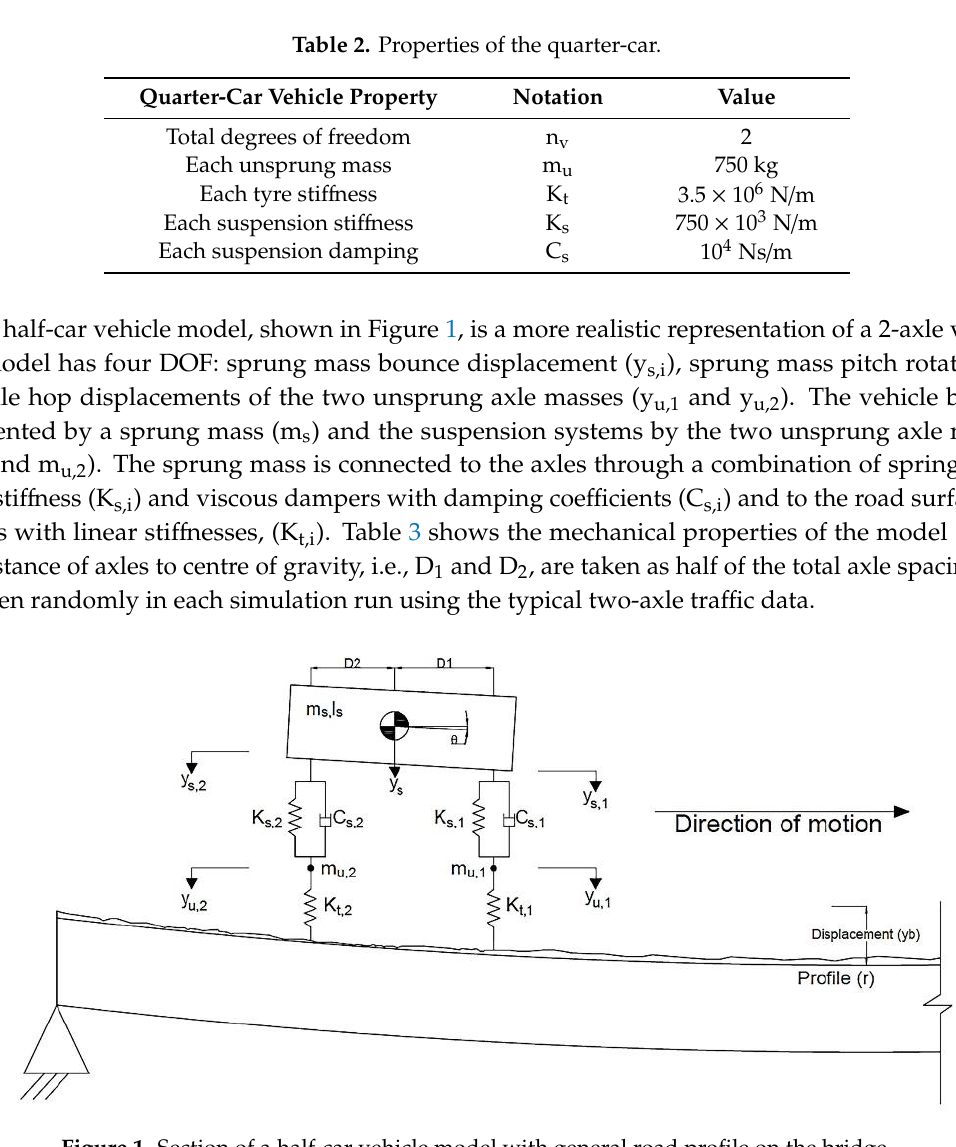
Table 2. Properties of the quarter-car.